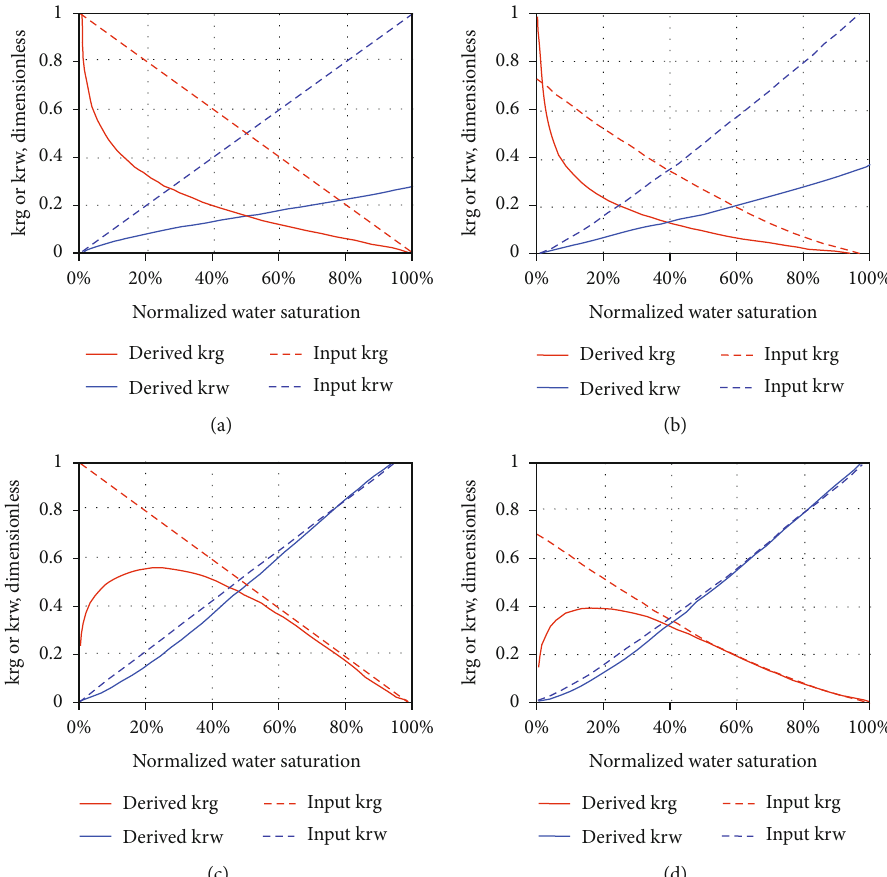
Figure 13: Comparison of derived and input relative permeability curves (modi fi ed from Clarkson et al.